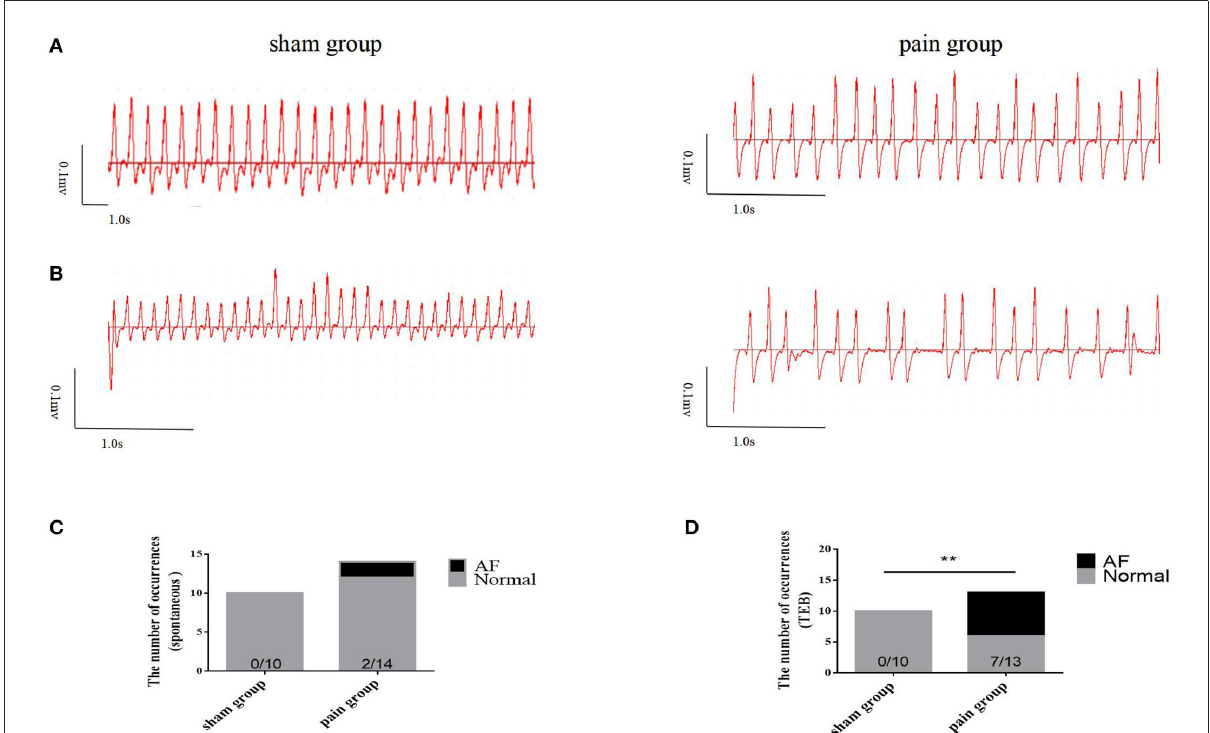
FIGURE2 The susceptibility to atrial fibrillation. (A) The basic ECG in sham and pain groups; (B) the ECG after transesophageal burst pacing (TEB) in sham and pain groups; (C) the occurrence number of spontaneous AF before TEB in sham and pain groups; (D) the occurrence number of AF after TEB in sham and pain groups. The results are expressed as numbers and percentages. Histograms represent numbers and percentages. ** represents p < 0.01 (two-tailed Fisher’s exact